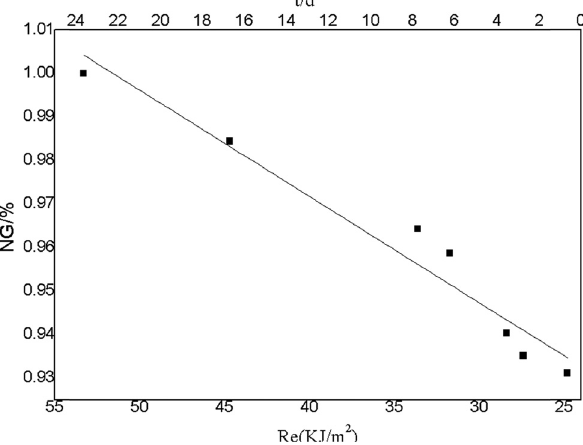
Figure 9: NG contents vs impact resistance of GaTo under aging at 75°C.